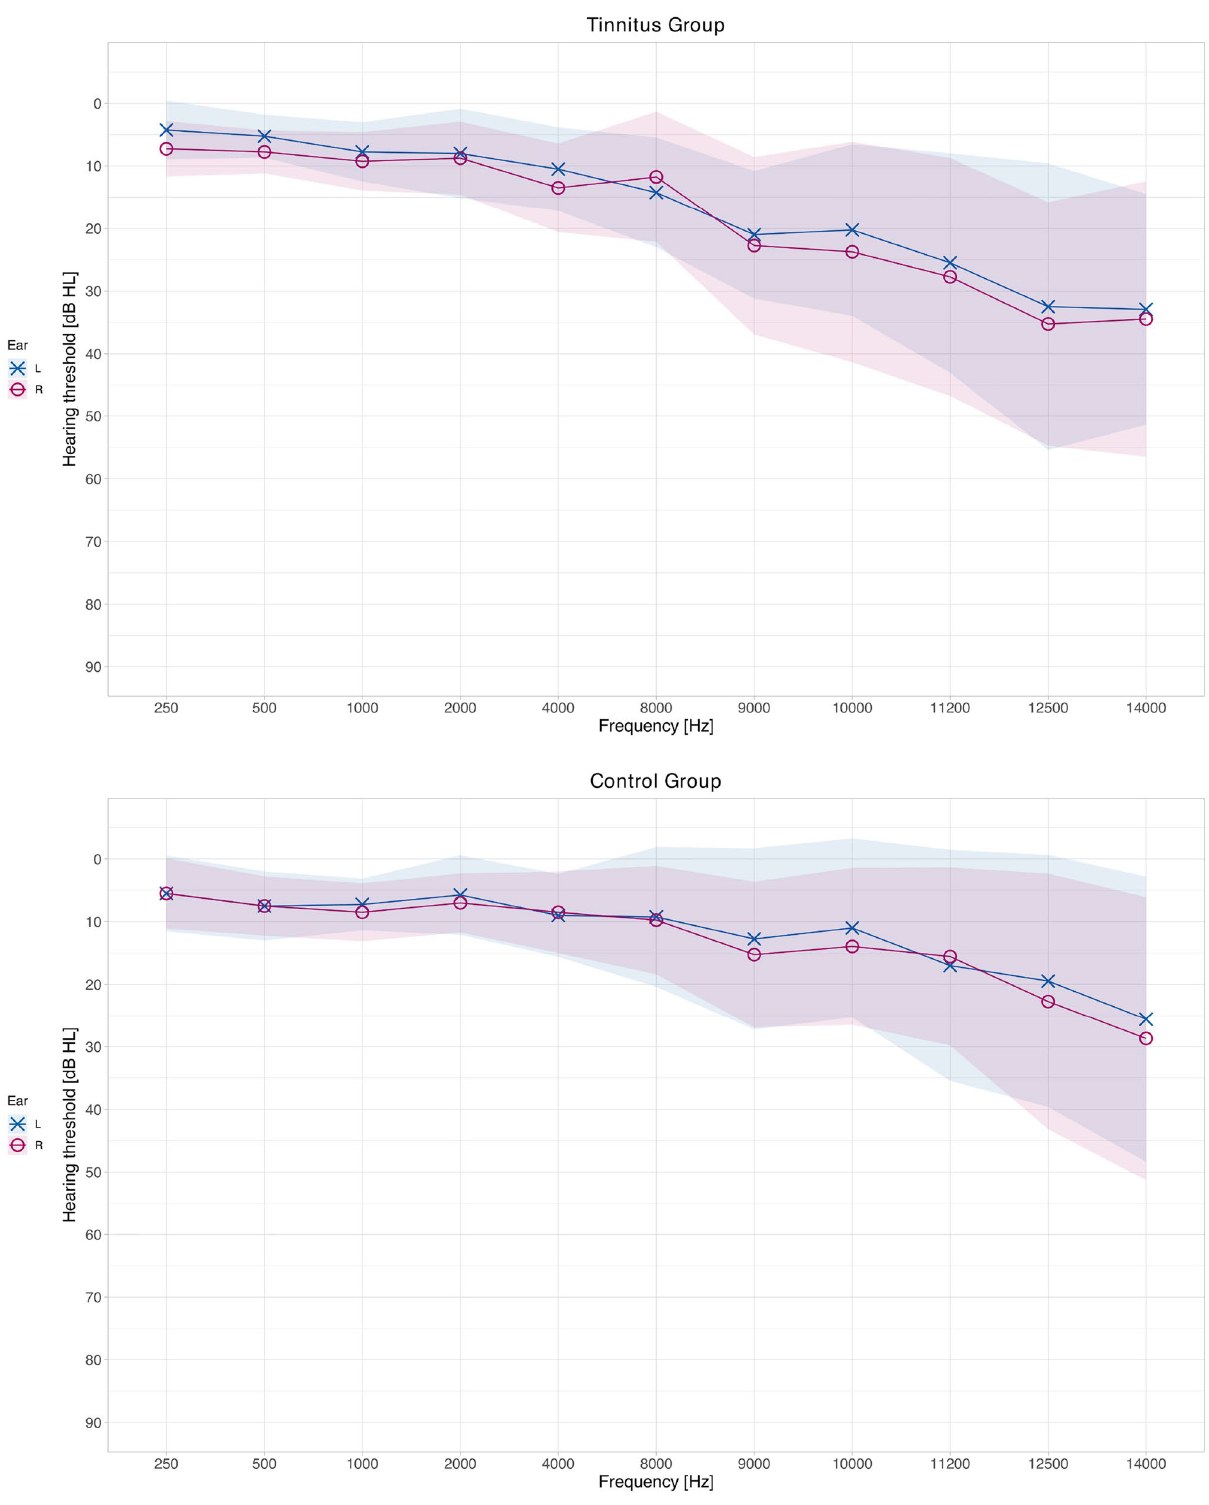
Figure 2. Hearing thresholds of both groups. The colored ribbons indicate standard